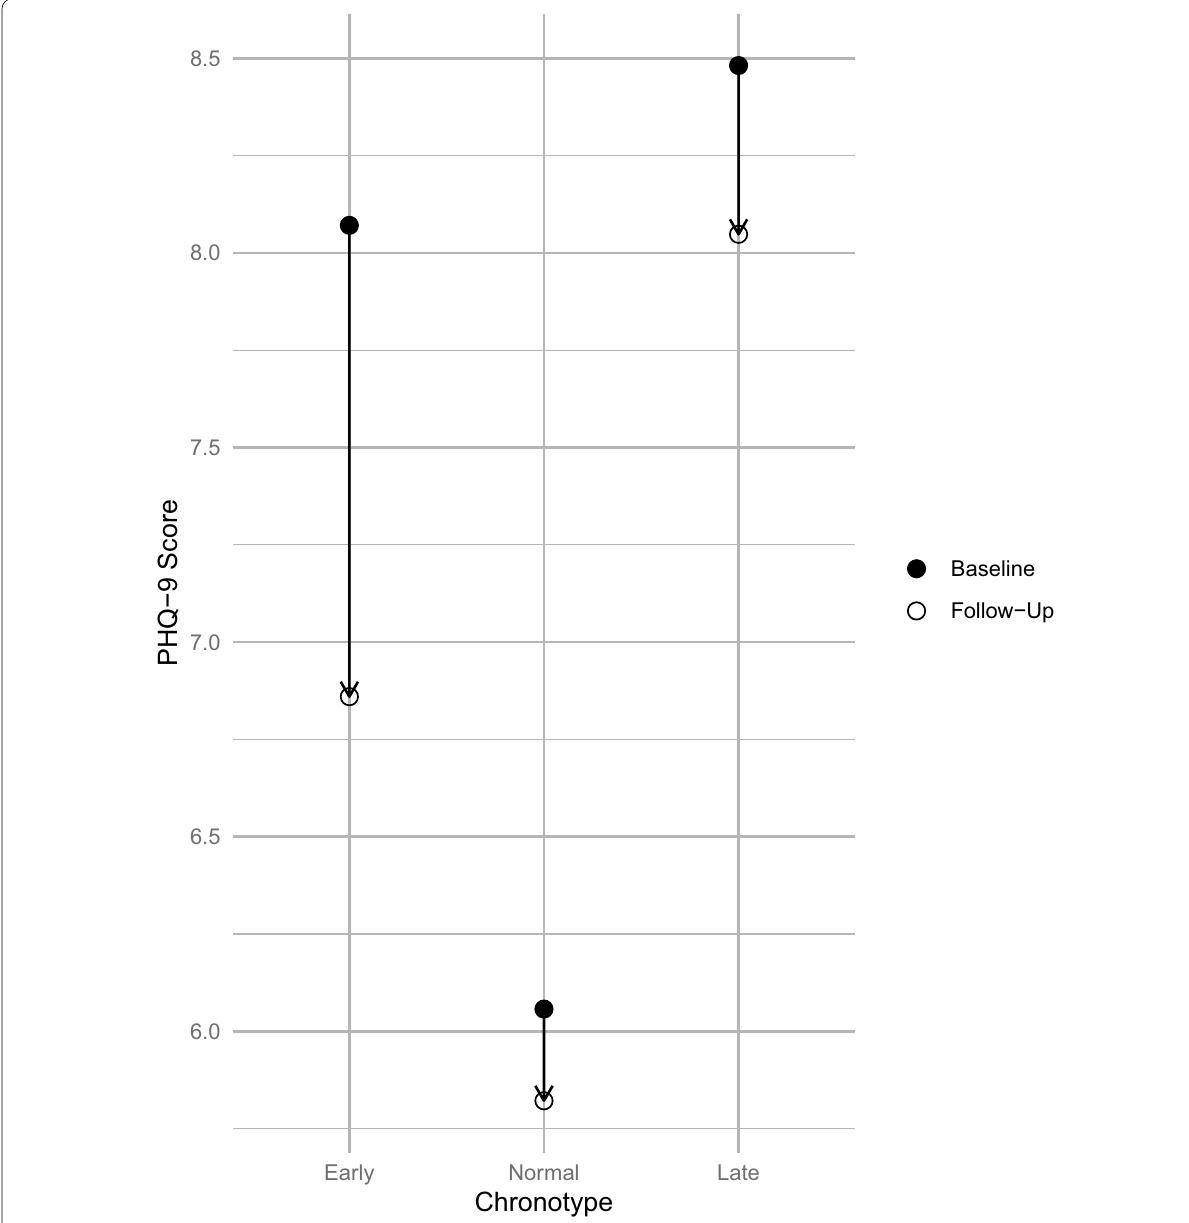
Fig. 2 The mean baseline PHQ-9 score and mean follow up PHQ-9 score of early, normal, and late